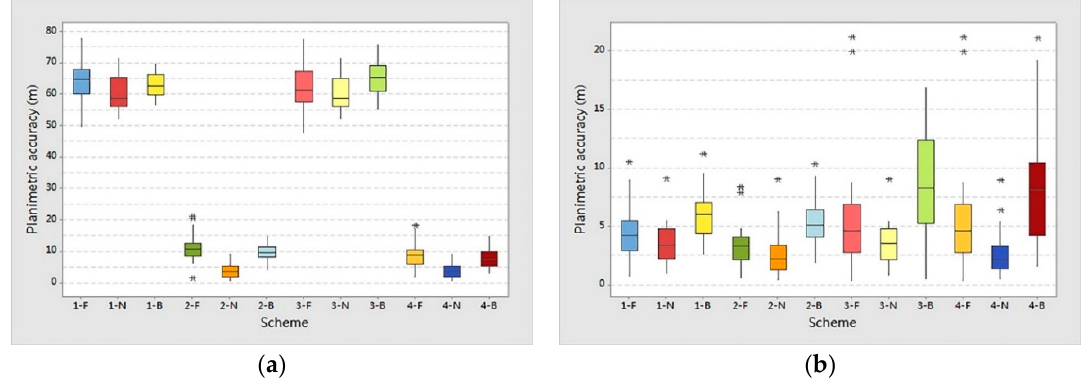
Figure 7. Box plots of ICPs. ( a ) The Songshan area; and ( b ) the Qiqihar area.